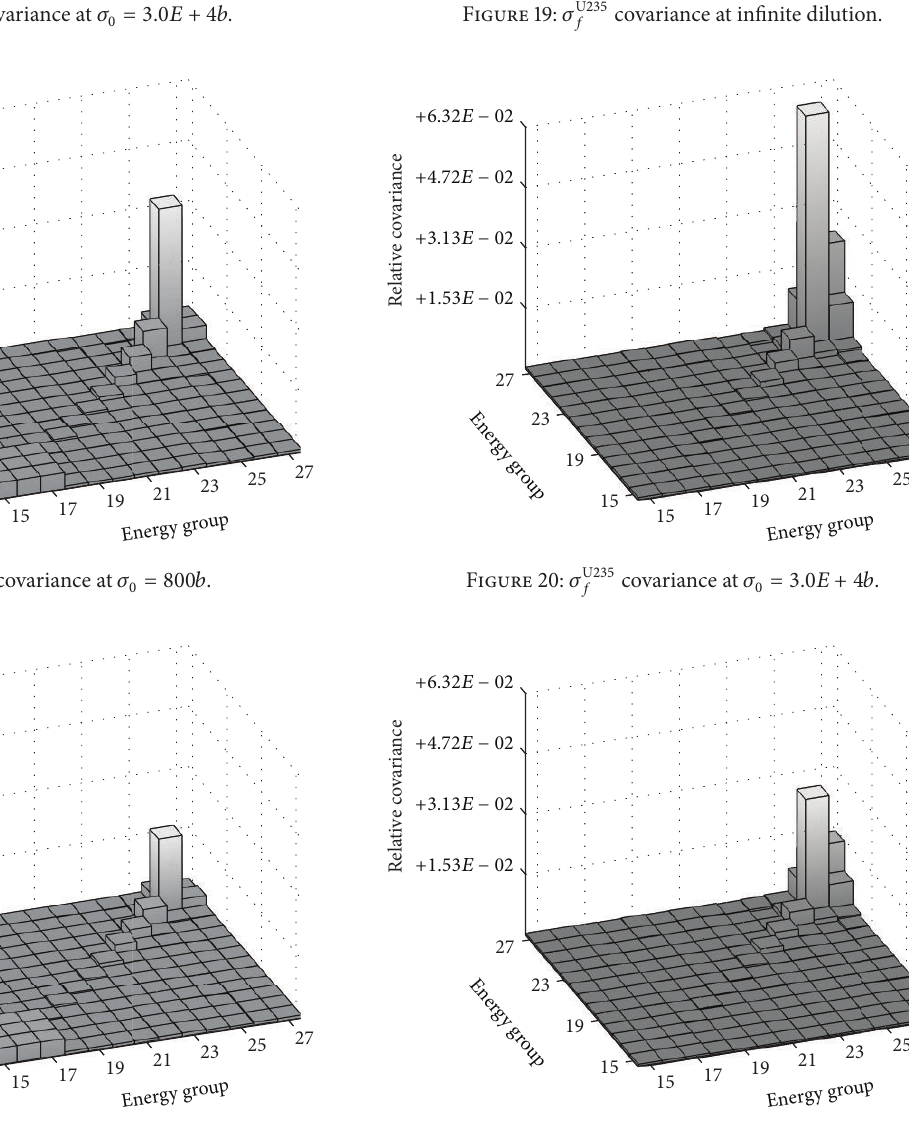
Figure 21: 𝜎 U 235 𝑓 covariance at 𝜎 0 = 800𝑏